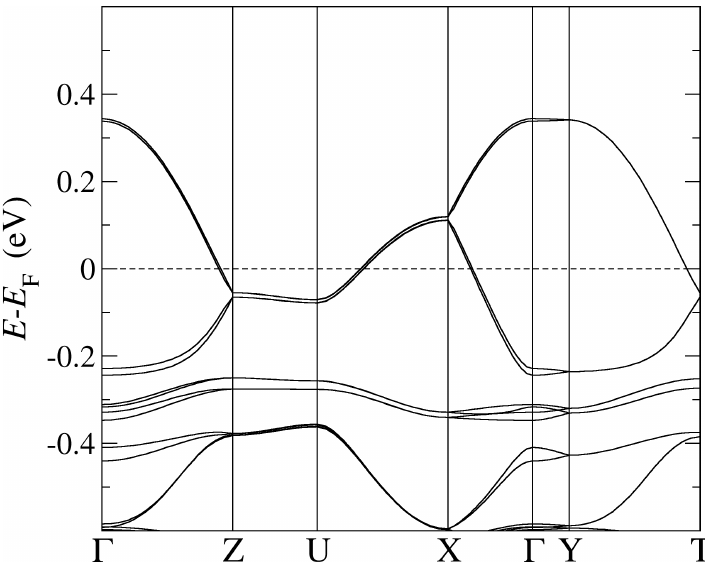
Figure 5. The band structure of κ -Cl obtained by using optB88-vdW and the pseudopotentials C, Cu pv . Γ = (0,0,0); X = (1/2,0,0); Y = (0,1/2,0), Z = (0,0,1/2) in the units of reciprocal lattice